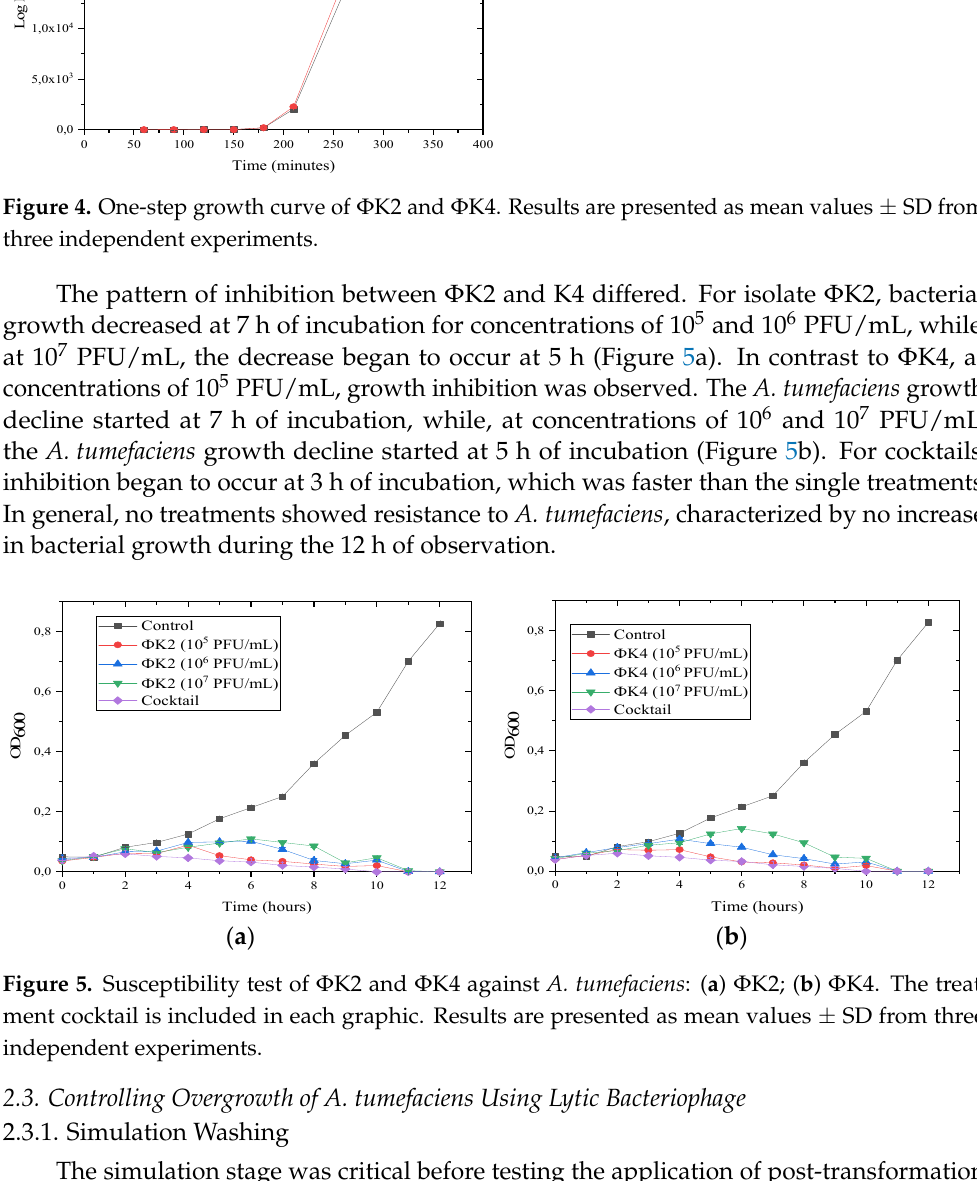
Figure 3. The rate of adsorption and the pH and thermal stability of Φ K2 and Φ K4: ( a ) thermal stability of Φ K2; ( b ) thermal stability of Φ K4; ( c ) pH stability of Φ K2 and Φ K4; ( d ) adsorption of Φ K2 and Φ K4 to the A. tumefaciens AGL1 WT host. The black arrow indicates the optimal adsorption value. Results are presented as mean values ± SD.